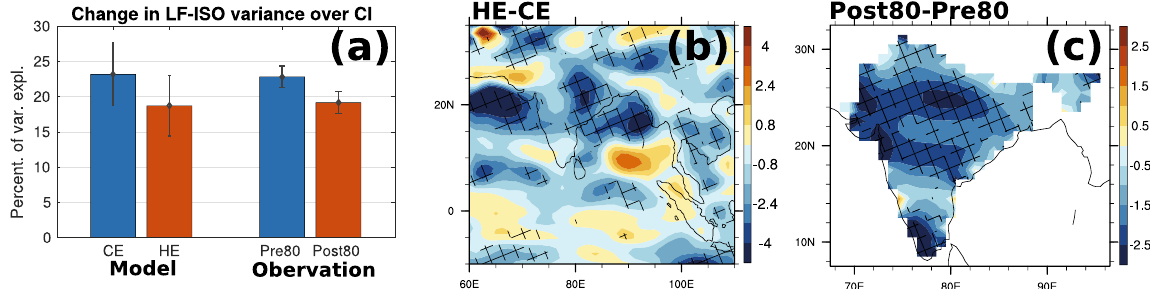
Figure 2. Change in strength of low-frequency ISO mode. ( a ) Explained variance of LF-ISO over central India from model (CE and HE) and observations (pre80 and post80). Both for model and observations, changes in mean are significant at 5% level (using t-test). Change in spatial distribution in the percentage of the variance explained (to the total rainfall) by LF-ISO from ( b ) Model and ( c ) Observations, during JJAS months. Hatched regions indicate regions where the changes are significant at 10% level (using t-test). Figure ( a ) is generated using MATLAB R2015a (https://in.mathworks.com/products/new_products/release2015a.html). Figures ( b ) and ( c ) are generated using NCAR Command Language 6.3.0